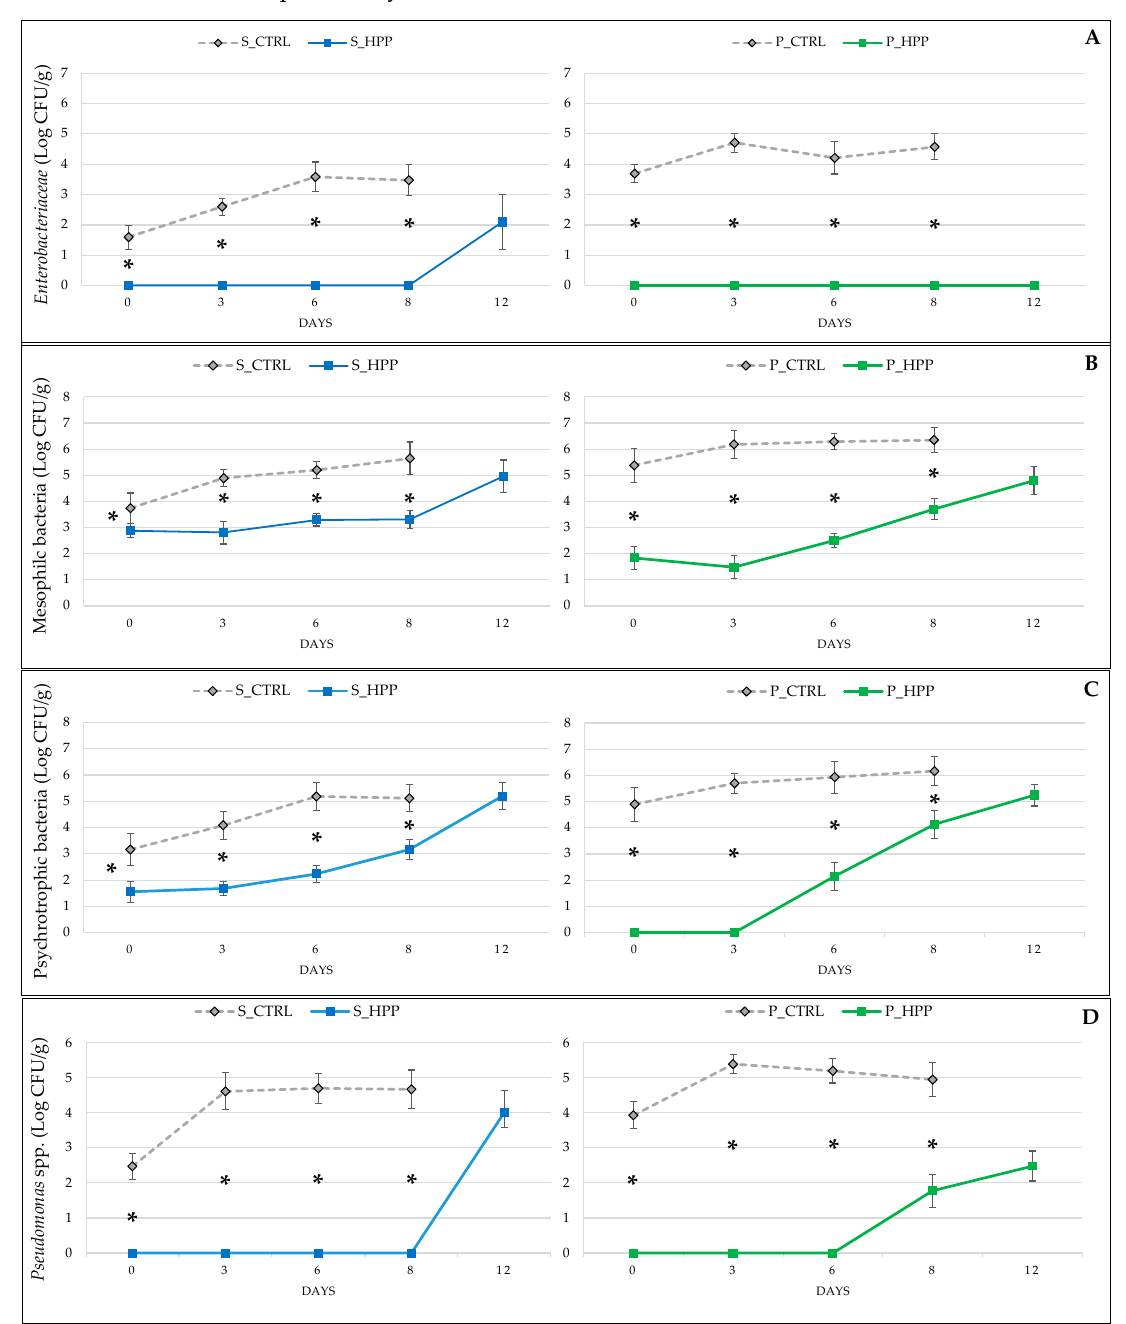
Figure 4. Effects of high-pressure treatment on ( A ) Enterobacteriaceae , counts of mesophilic and psychrotrophic bacteria ( B and C , respectively) and Pseudomonas spp. ( D ) on salmon (S_CTRL and S_HPP) and plaice (P_CTRL and P_HPP) fillets during shelf-life. The line graphs show mean ( n = 3) ± standard deviation. Significant effect of groups is highlighted by asterisks: * p ≤ 0.05.